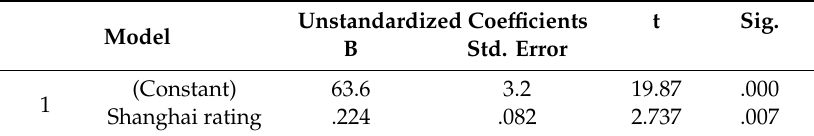
Table 11. Model coe ffi cients simple regression